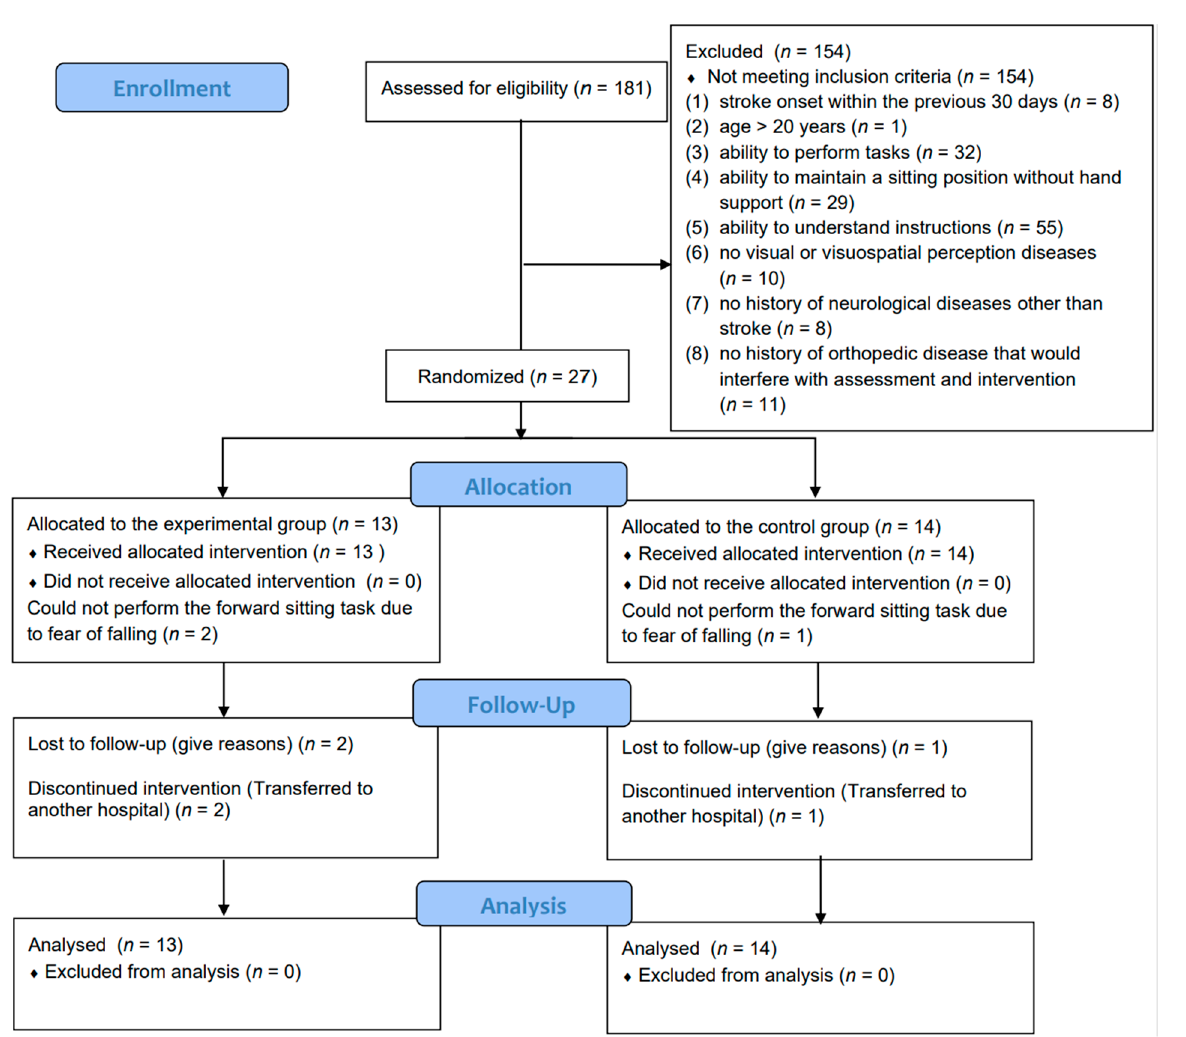
Experimental Group